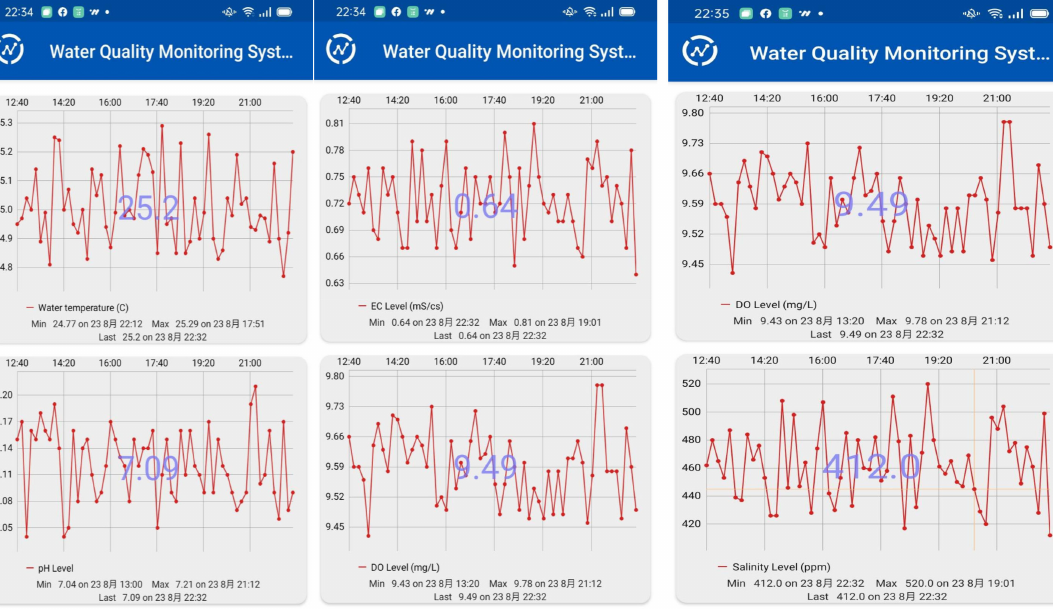
Figure 5. Snapshot of ThingView APP for water quality monitoring